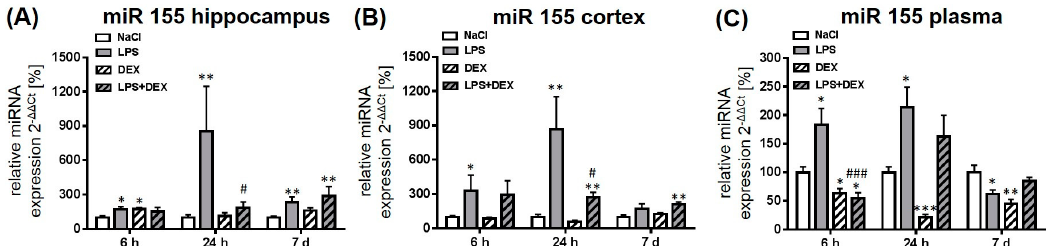
Figure 5. Representation of miR 155 after LPS and dexmedetomidine treatment in the hippocampus ( A ), cortex ( B ), and plasma ( C ). Results are shown as mean ± SEM ( n = 6–8 per group). Data are normalized to levels of saline-treated rats (control = 100%). * p < 0.05, ** p < 0.01, and *** p < 0.001 represent the difference compared to saline-treated groups. # p < 0.05 and ### p < 0.001 represent the difference between LPS and LPS in combination with dexmedetomidine-treated groups.